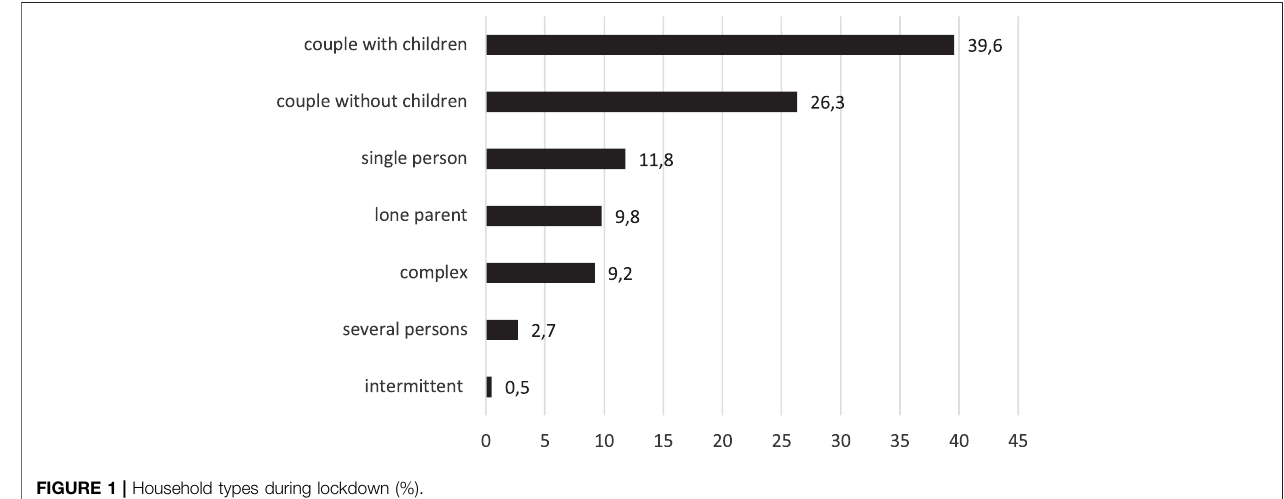
FIGURE 1 | Household types during lockdown (%). Source: Impacto Social da Pandemia. Estudo ICS/ISCTE Covid-19. Note: N (cid:1)